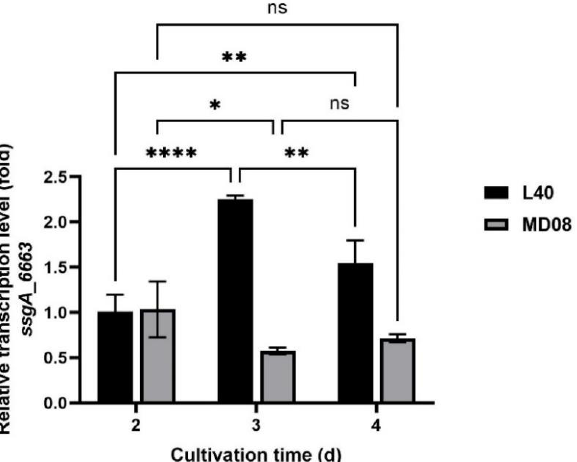
Figure 4. Relative transcription of ssgA_6663 gene in L40 and MD08 at different culture times. RNA sample data were obtained from days 2, 3, and 4 of fermentation. Gene expression level was determined by 2 − ∆∆ Ct method, and the values are means ± SD of triplicate analyses. Transcription data on day 2 was were set as the baseline for comparison. 16s rRNA was used as the internal control. Three biological replicates were performed in fermentation experiments. Significant differences were analyzed by one-way ANOVA, *, p < 0.05, **, p < 0.01, ****, p < 0.0001, ns, no significant. MD08, mutant with adpA_1075